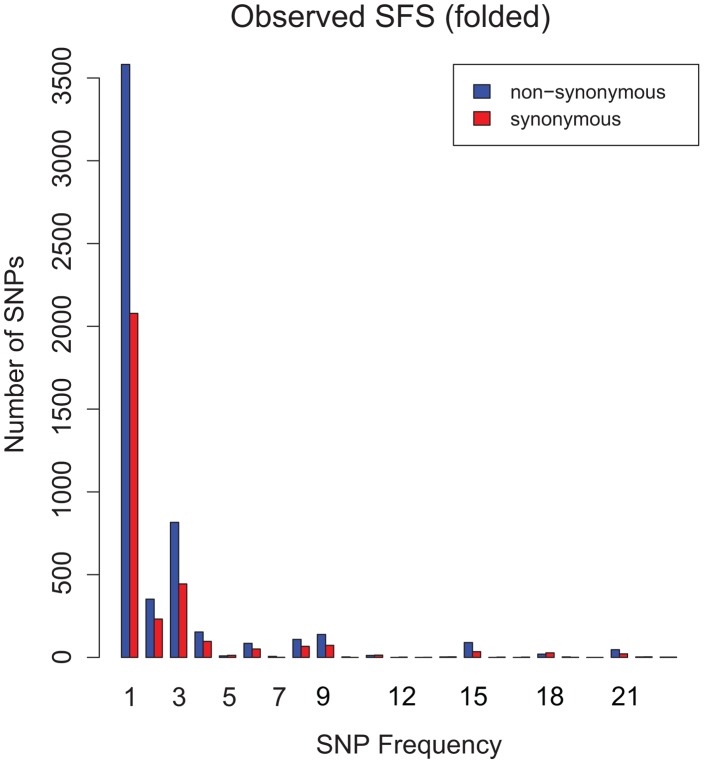
Observed folded site frequency spectrum (SFS) of synonymous and non-synonymous SNPs.Numbers of single nucleotide polymorphisms (SNPs, Y axis) in frequency classes 1–23 (X axis). The SFS is leptokurtic and bumpy, consistent with purifying selection and linkage of sites (see text).